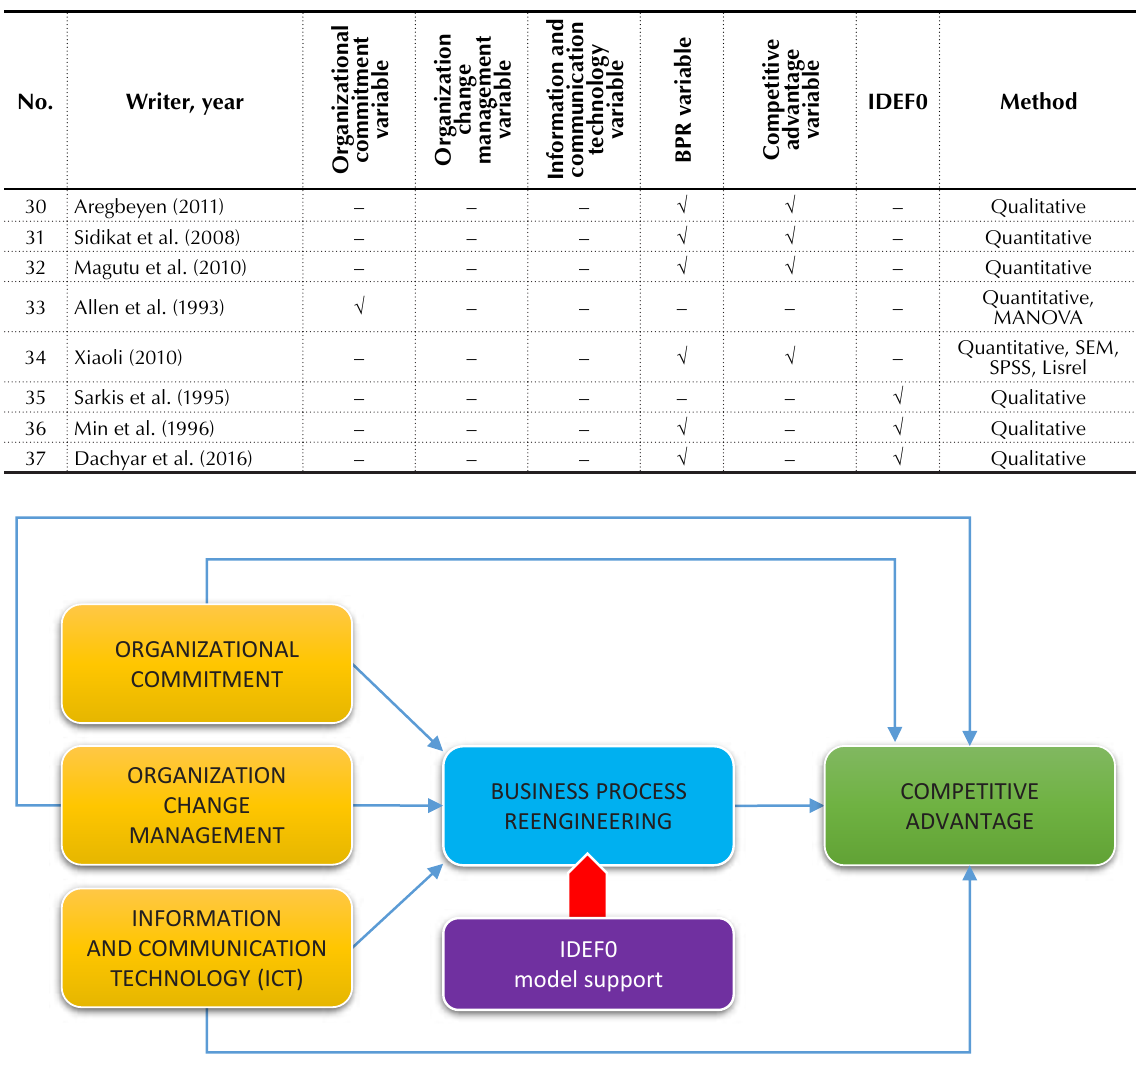
Figure 10. Paradigm